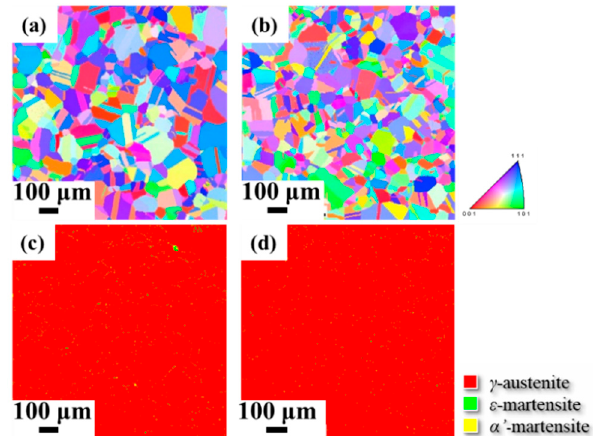
Figure 1. Electron back-scattered diffraction (EBSD) analysis of test blocks before wear test: inverse pole figure (IPF) maps of ( a ) SUS304 and ( b ) SUS316 and corresponding phase maps (PM) of ( c ) SUS304 and ( d ) SUS316.